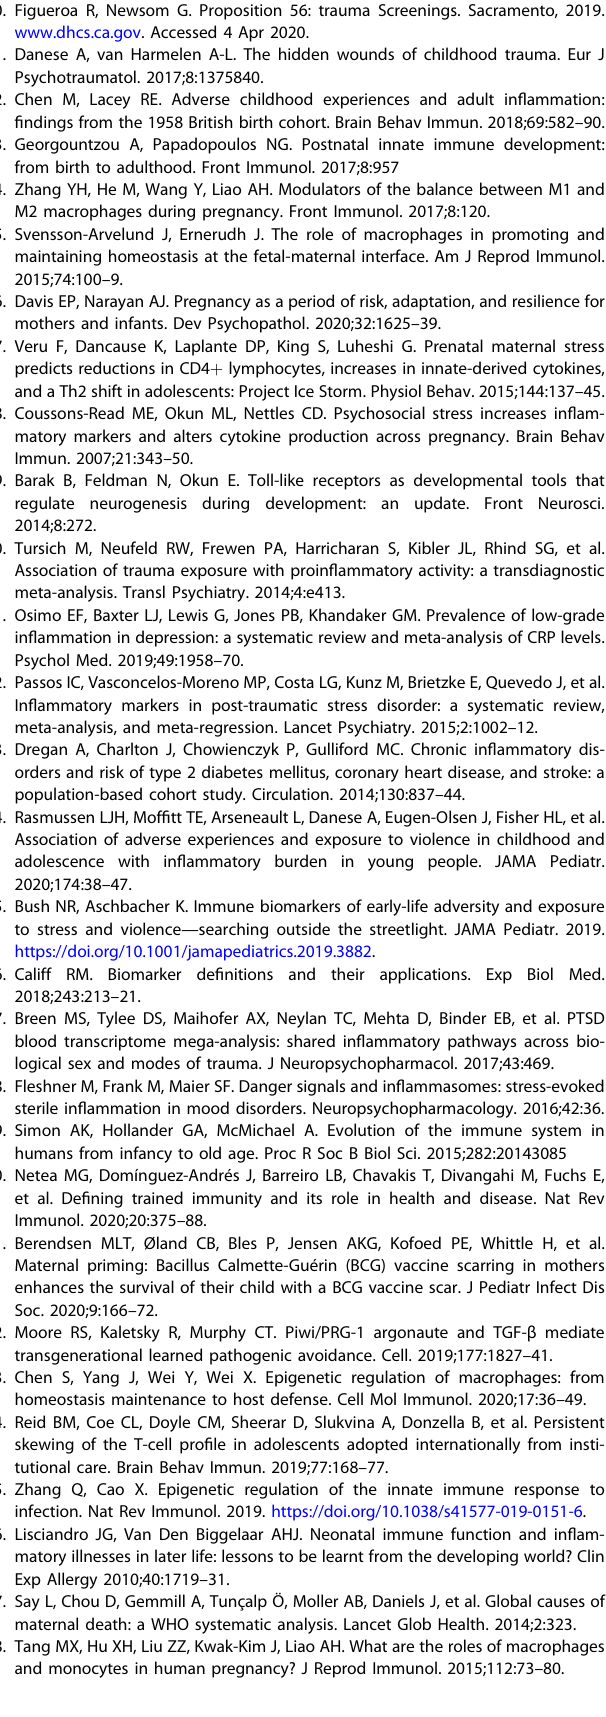
10. Figueroa R, Newsom G. Proposition 56: trauma Screenings. Sacramento, 2019. www.dhcs.ca.gov. Accessed 4 Apr